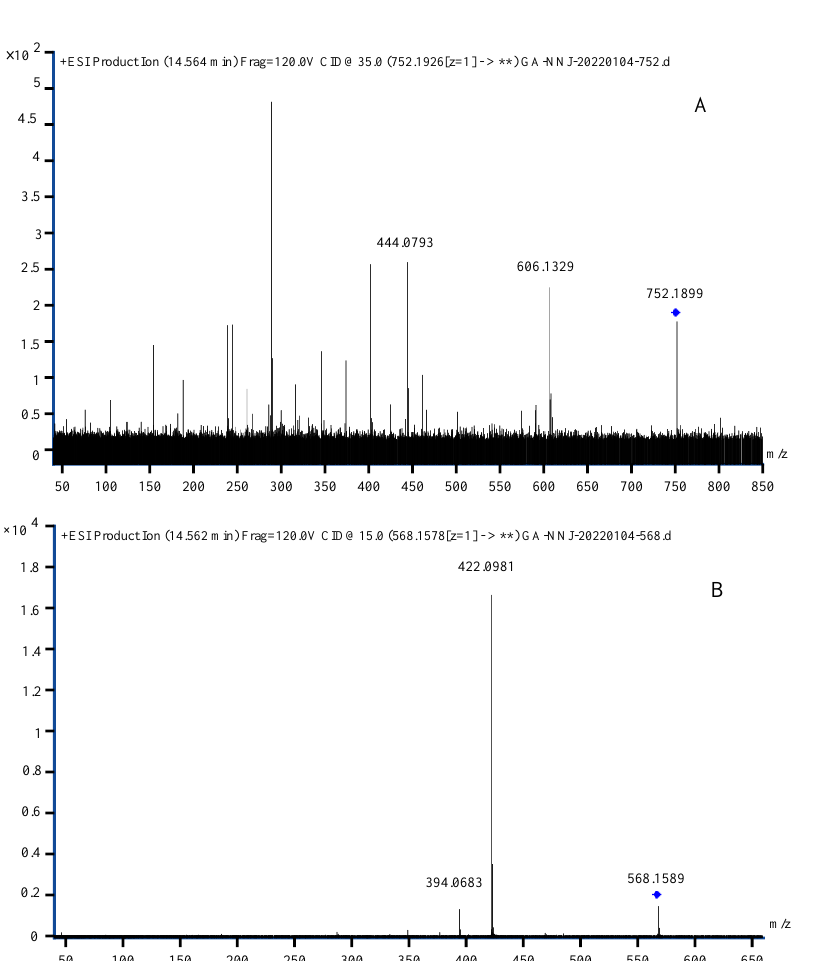
Figure 7. PIMS of m / z 752.1926 ( A ) and m / z 568.1578 ( B ) found in the extract of Arabidopsis thaliana (L.) exposed to Tabun. The blue sign was used to mark the precursor ion. Table 5. The deviations between calculated and observed m / z values of each fragment derived from compound 5.